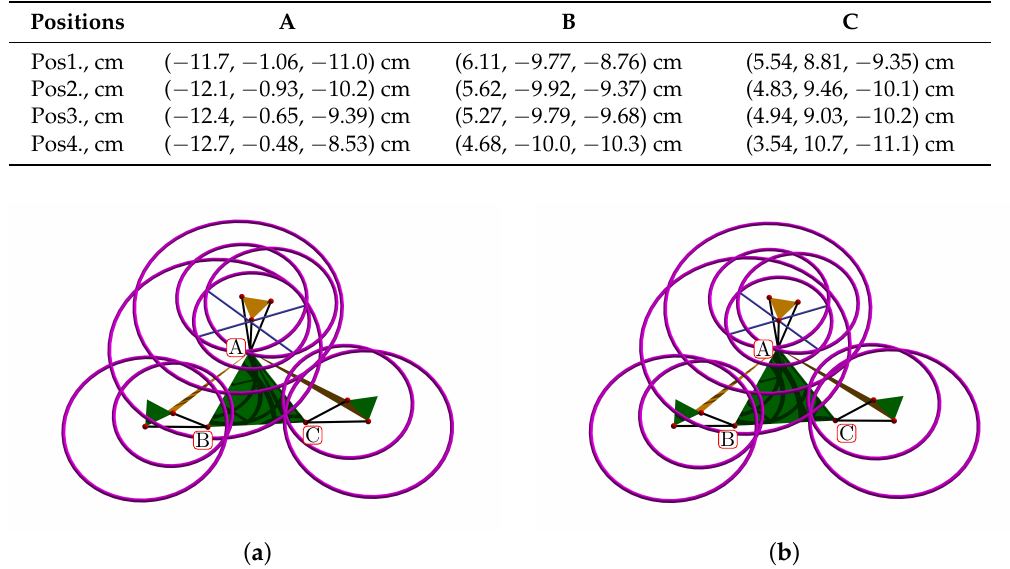
Figure 34. First two trilateration results: ( a ) position 1, ( b ) position